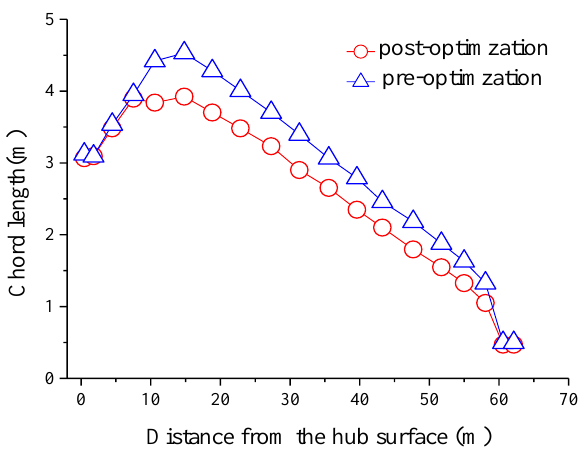
Figure 21. Distribution of the chord length at low wind speed before and after optimization.